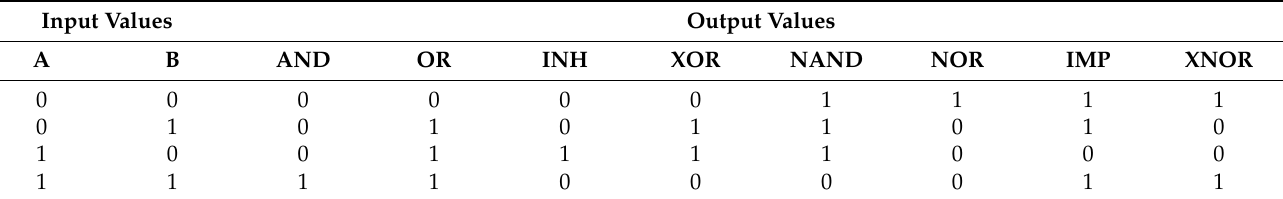
Table 1. Fundamental Boolean logic